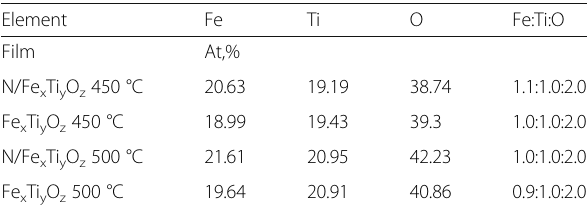
Table 2 The atomic percentage and ratio of the elements of the films obtained by EDS technique Element Fe Ti Fe:Ti:O